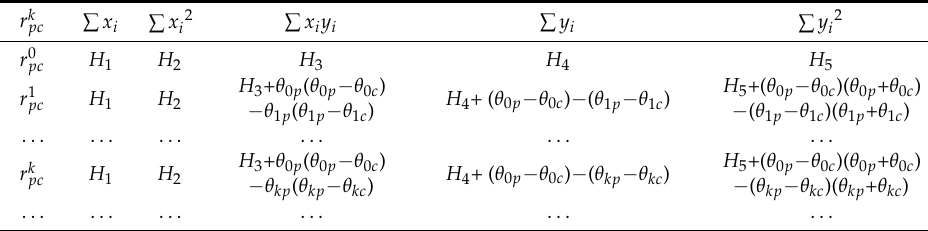
Table 1. Optimized calculation of r k pc .